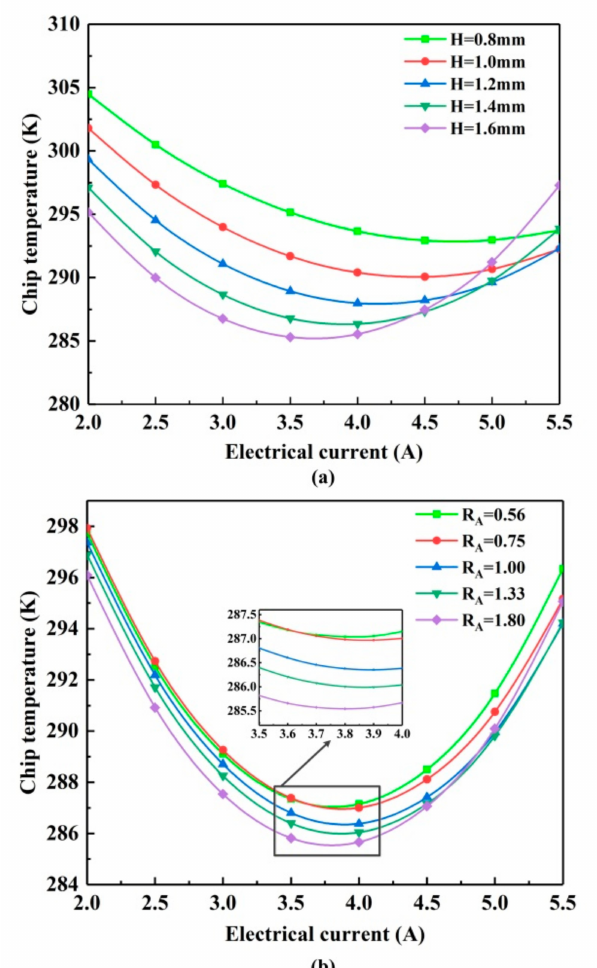
Figure 5. Variation of the chip temperature with the electrical current for ( a ) di ff erent leg heights when R A = 2.5 and ( b ) di ff erent cross-sectional area ratios of the cold side to hot side for the legs when H = 1.6 mm.